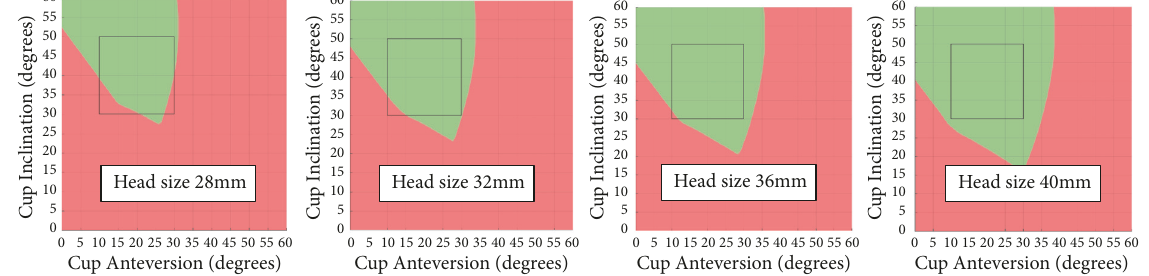
Figure 6: Impingement with different head sizes. At stem anteversion of 10 ∘ for stem 2.